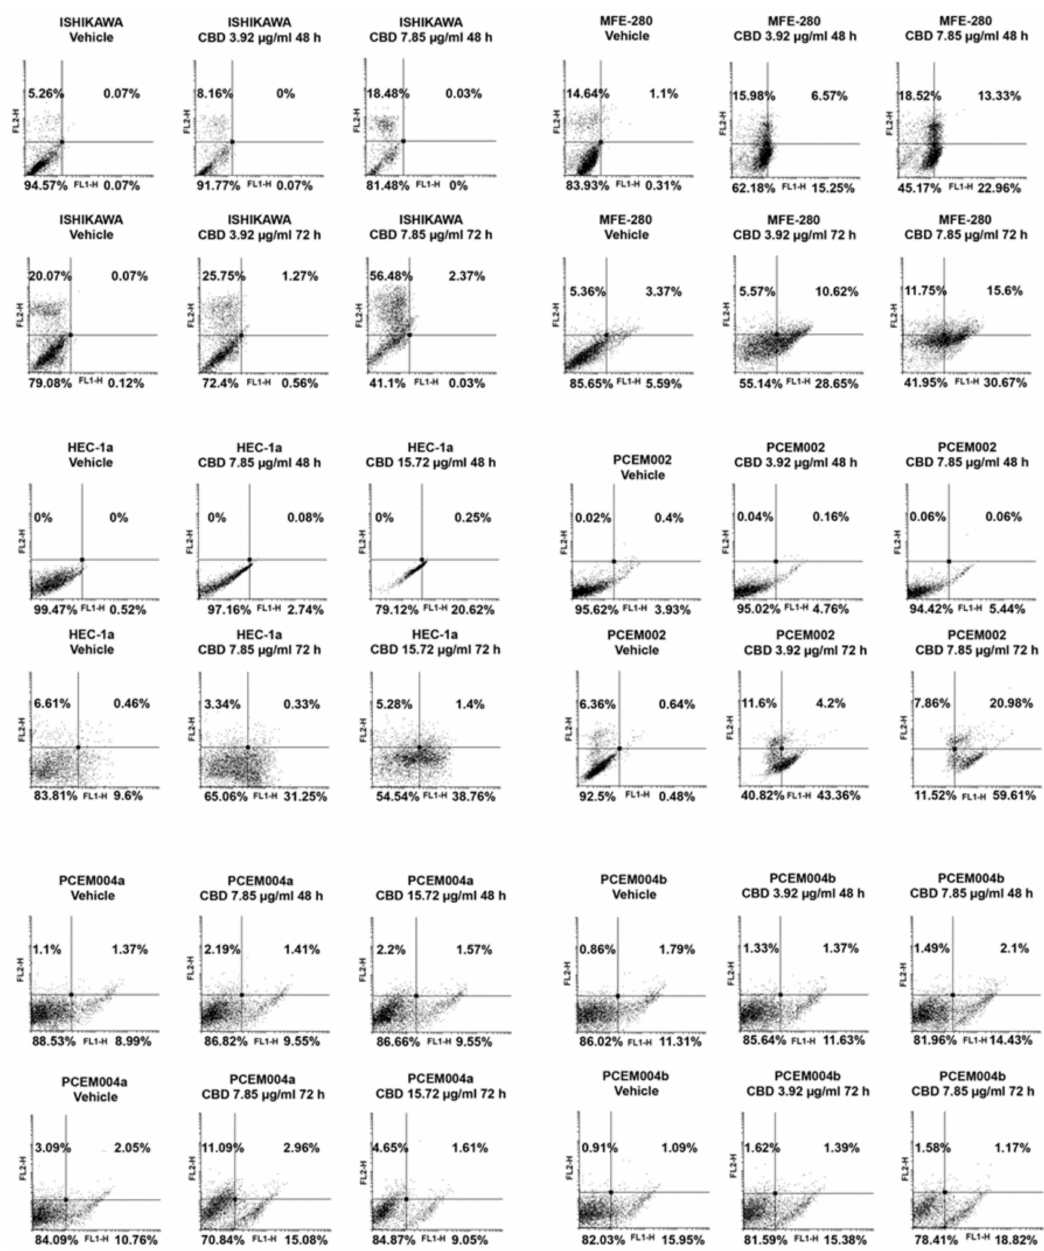
Figure 9. CBD induced cell death in EC cell lines. EC cell lines were treated with CBD for 72 h. Flow cytometric analysis was performed by Annexin V and PI double-staining. FL1-H fluorescence signal is in x -axis. Data represent the percentage of PI and / or Annexin V + cells and are representative of one of three separate